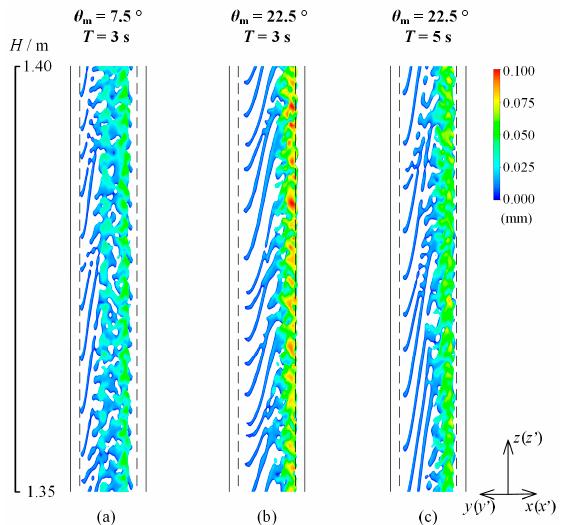
Figure 16. Phase distribution with different amplitudes and periods ( 𝑡 = 𝑇/2 ). ( a ) 𝜃 (cid:2923) = 7.5° , 𝑇 = 3 s ; ( b ) 𝜃 (cid:2923) = 22.5° , 𝑇 = 3 s ; ( c ) 𝜃 (cid:2923) = 22.5° , 𝑇 = 5 s .